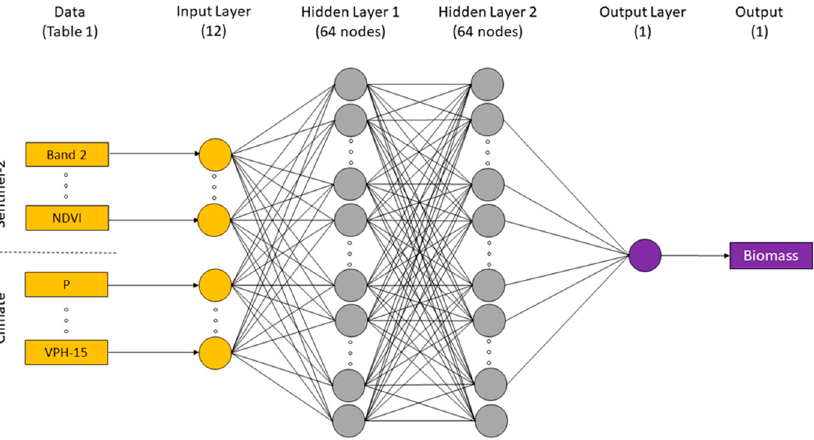
Figure 6. Indicative architecture of the multilayer perceptron neural network model used in this